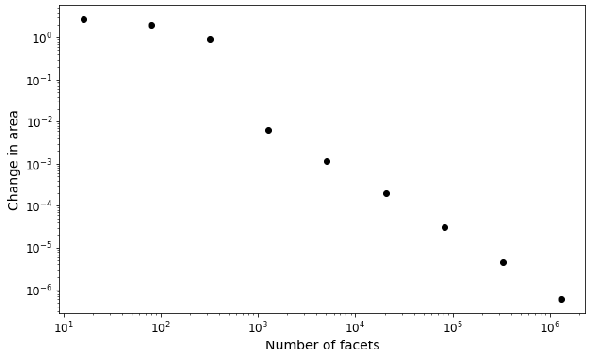
Figure 14. Convergence of the area after successive refinements of the minimal surface for a rhombus. Here the side length is 1, vertex angle is π/ 3 , and cutoff is (cid:15) = 0 . 03 . The large change at around 1300 facets is due to a switch from the linear to quadratic surface interpolation model. After this point the graph is nearly linear, with the area modifications growing smaller by more than an order of magnitude at each refinement. Assuming such behavior continues, convergence is